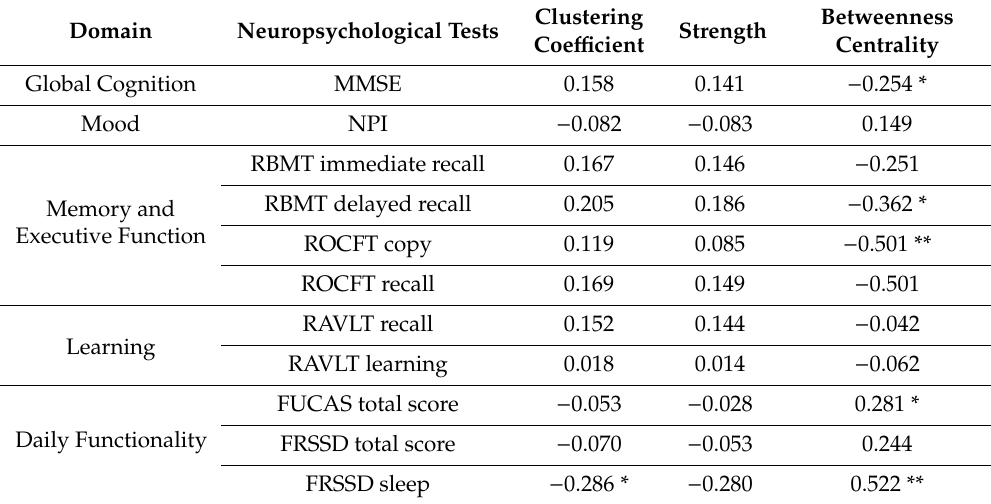
Table 6. Pearson correlation between network properties and neuropsychological tests for all participants at a local